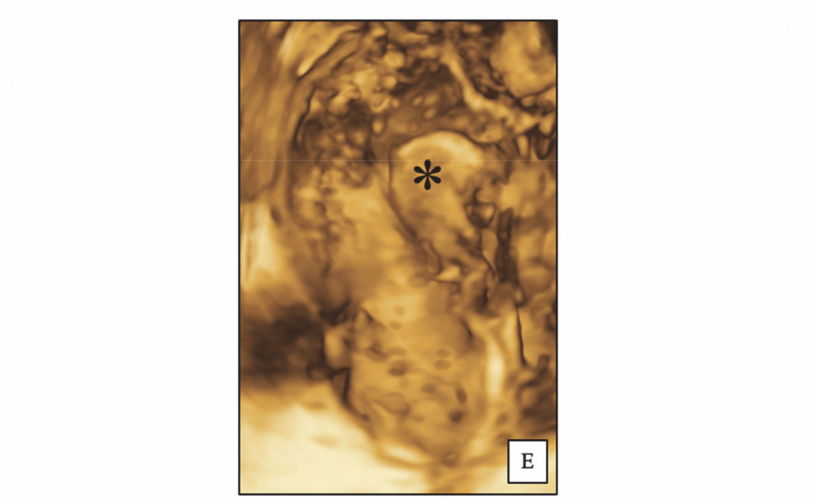
Figure 2. Rectal endometriotic nodule. ( A ) CTC: 3D reconstruction of dilated colon, showing rectal stenosis (arrow) by an endometriotic nodule. ( B ) CTC: sagittal 2D image, the rectal nodule (asterisk) causes stenosis of the intestinal lumen. ( C ) CTC: pseudoendoscopic view and 3D endoluminal fly-through reconstruction, showing normal rectal lumen. ( D ) CTC: pseudoendoscopic view and 3D endoluminal fly-through reconstruction, showing rectal stenosis by the endometriotic nodule. ( E ) 3D-RWC-TVS showing the rectal nodule (asterisk). The nodule has a largest diameter of 2.8 cm; the distance between the lower margin of the nodule and the anal verge is 10